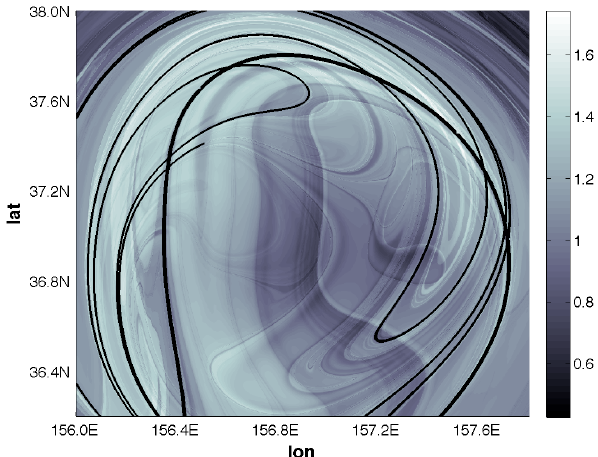
Fig. 6. Stable and unstable manifolds overlapped on the function M at day 17 April for τ = 72 days. There is a coincidence between singular features of M and